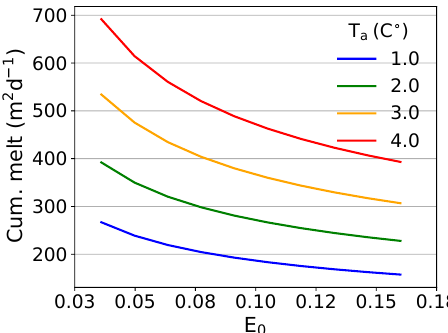
Figure 7. Cumulative melt rate in the LP as a function of entrain- ment parameter E 0 for q sg = 10 − 3 m 2 s − 1 in four different well- mixed ambient Temperatures T a , in a tidewater